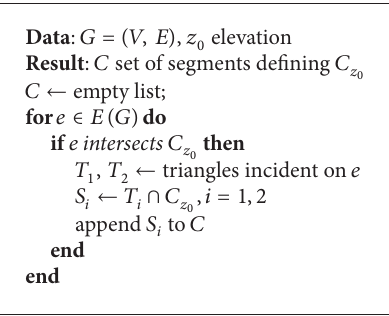
Algorithm 4: Contour lines algorithm.